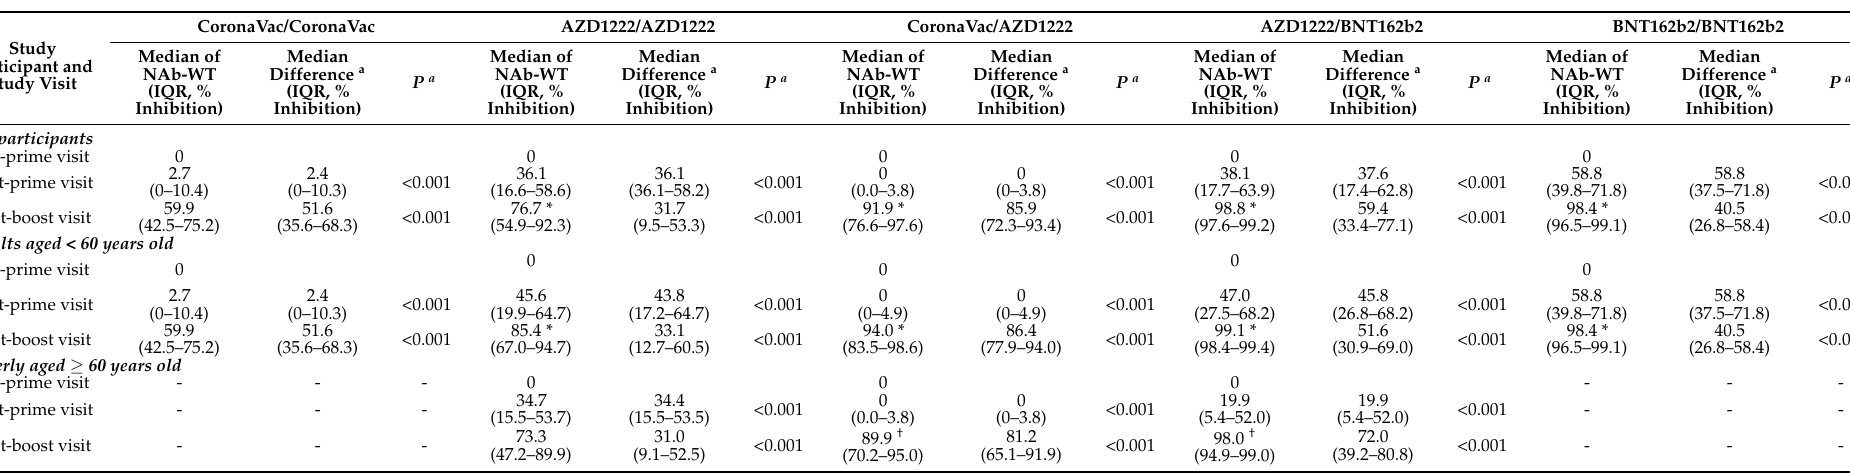
Table 3. The median levels of neutralizing antibodies against wild-type SARS-CoV-2 following a primary series of COVID-19 vaccination, stratified by the COVID-19 vaccine